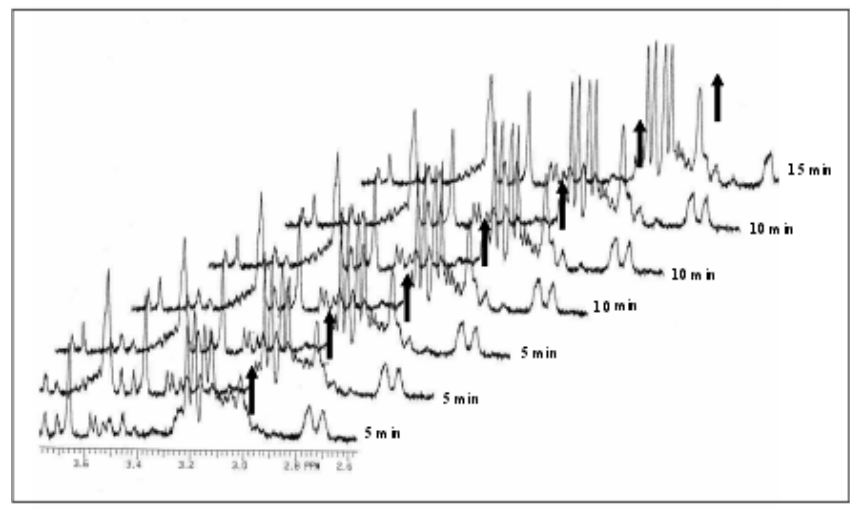
Figure 5. 1 H-NMR spectra of the reactions of [PdCl(dien)] + (5 mM) with enzyme as a function of time. Reproduced from